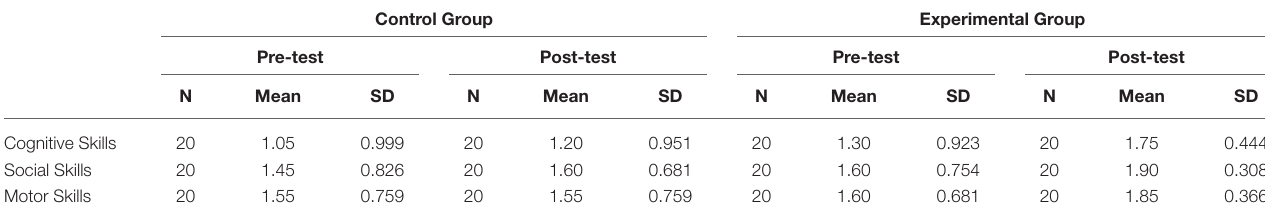
TABLE 2 | Descriptive statistics of children skills for both